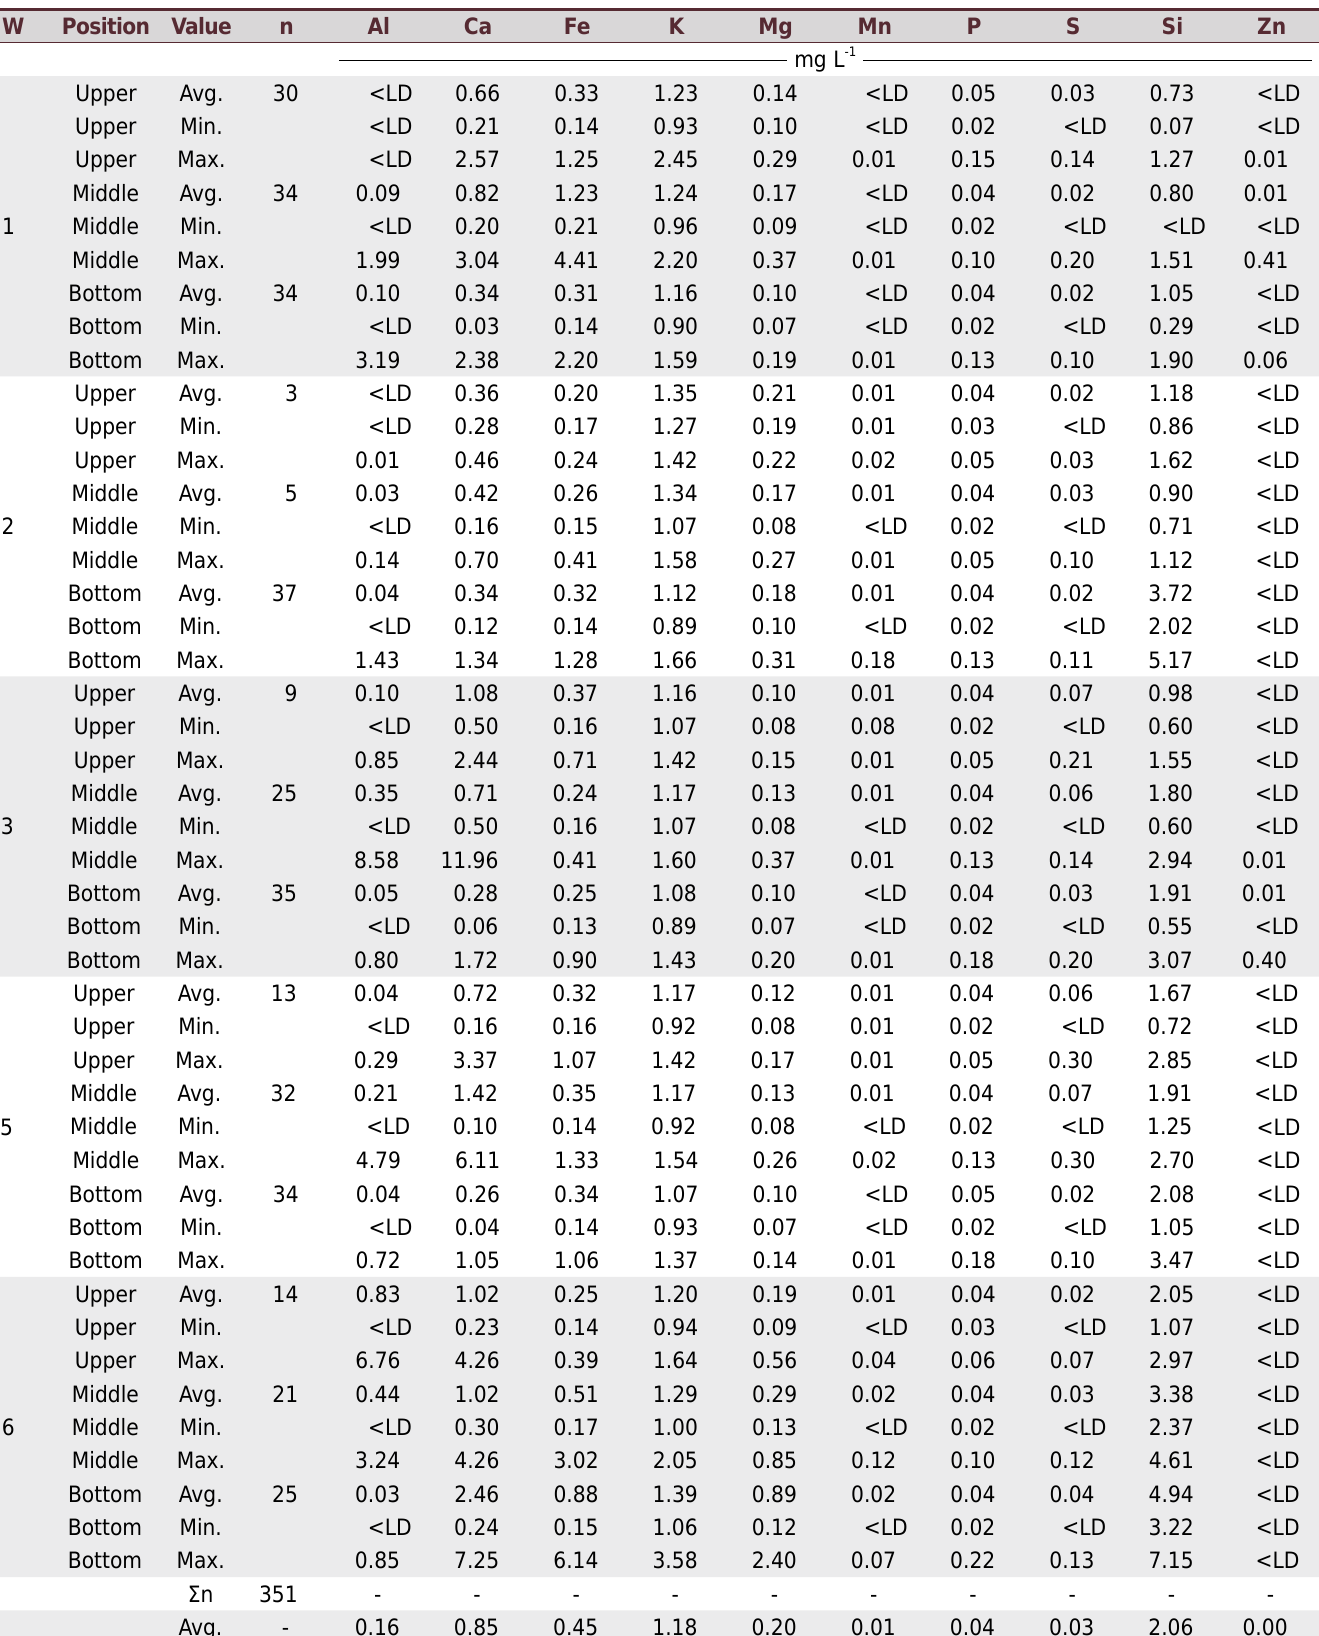
Table 2. Elemental composition obtained by ICP-OES of water from Cerrado wetlands, Uberlândia region, Minas Gerais State, from September 2014 to September 2015 W Position Value n Al Ca Fe K Mg Upper Avg. 30 <LD Upper Min. <LD Upper Max. Middle Avg. 34 Middle Min. 1 Middle Max. Bottom Avg. 34 Bottom Min. <LD Bottom Max. Upper Avg. 3 <LD Upper Min. <LD Upper Max. Middle Avg. 5 Middle Min. 2 Middle